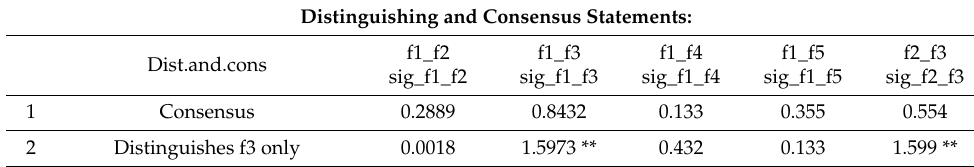
Table A3. Factor characteristics. Distinguishing and consensus